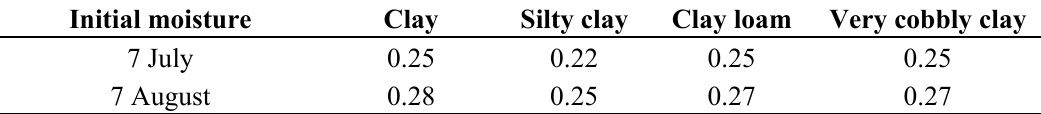
Table 4. Initial soil moisture conditions for both events.